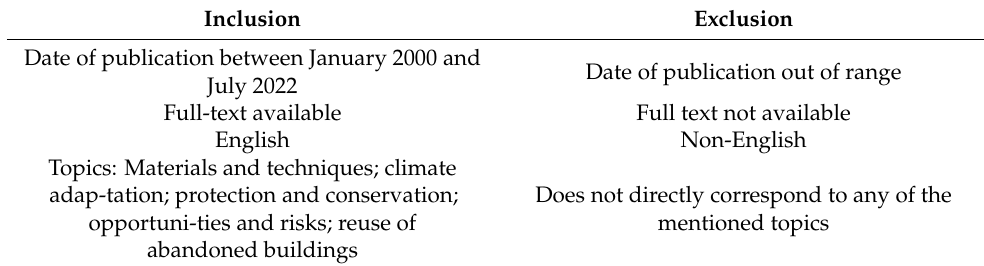
Table 1. Inclusion and exclusion criteria for the literature selection.